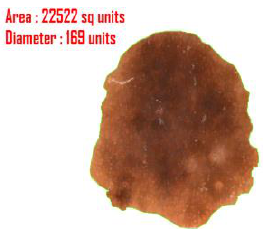
Figure 12. Outcome of diameter and area of the segmented lesion.